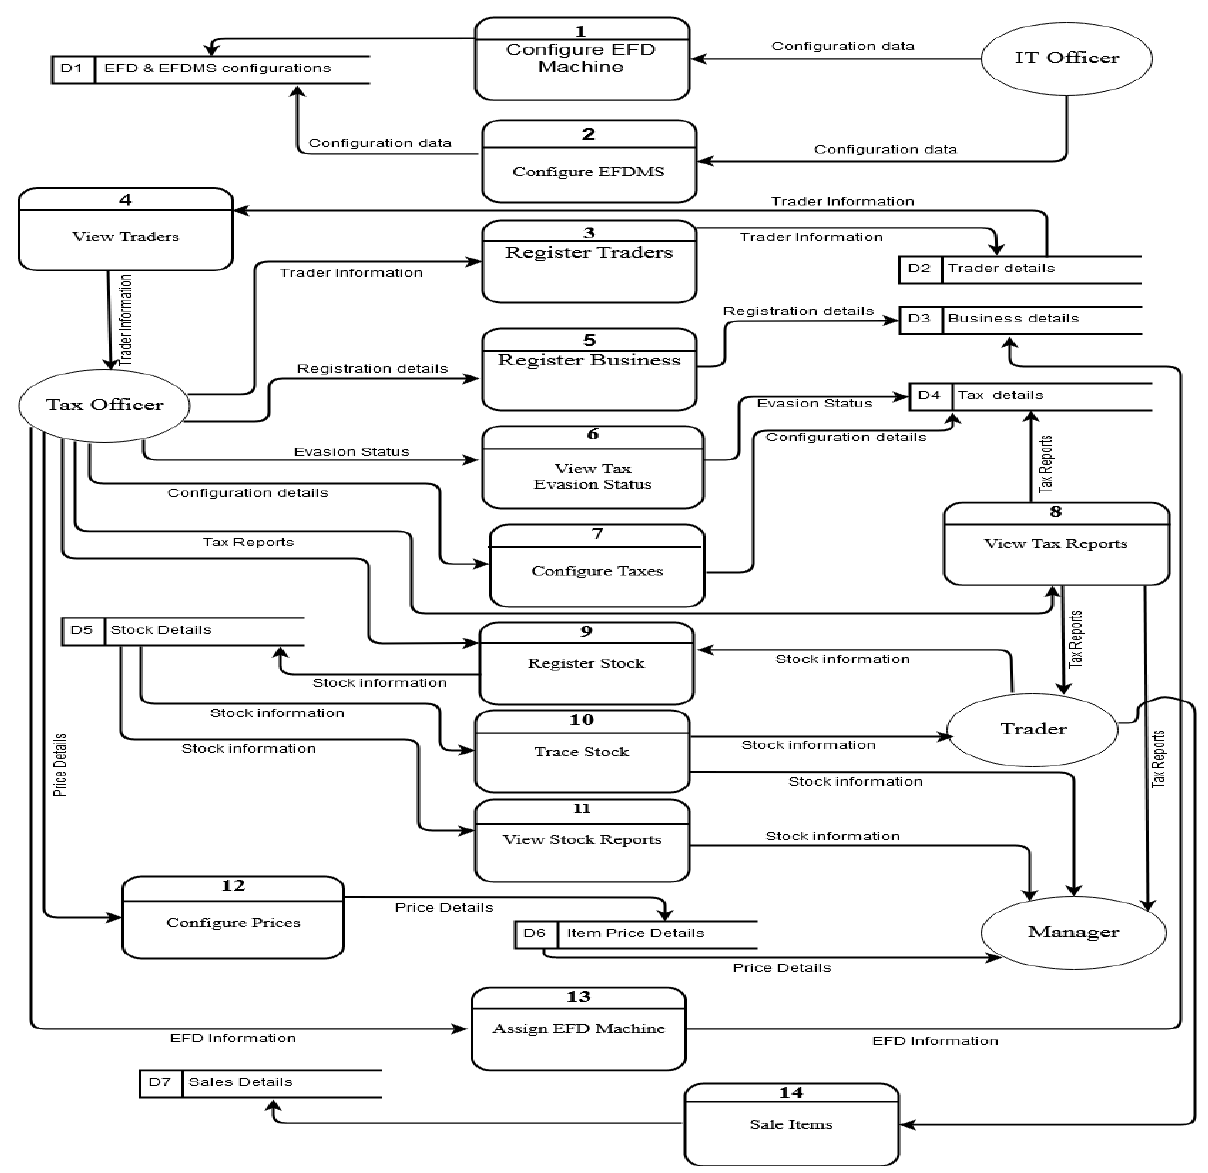
Figure 2. DFD level 1 of the developed